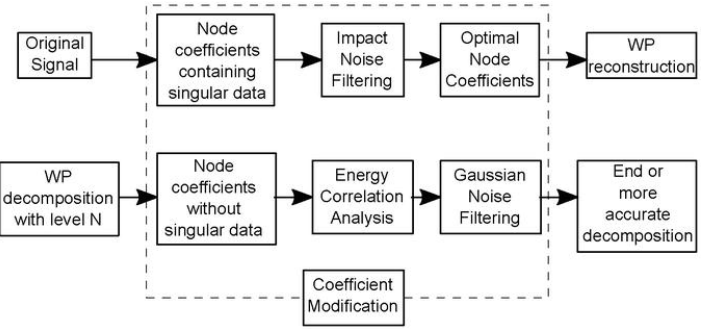
Fig. 5 Business and device/link correlation